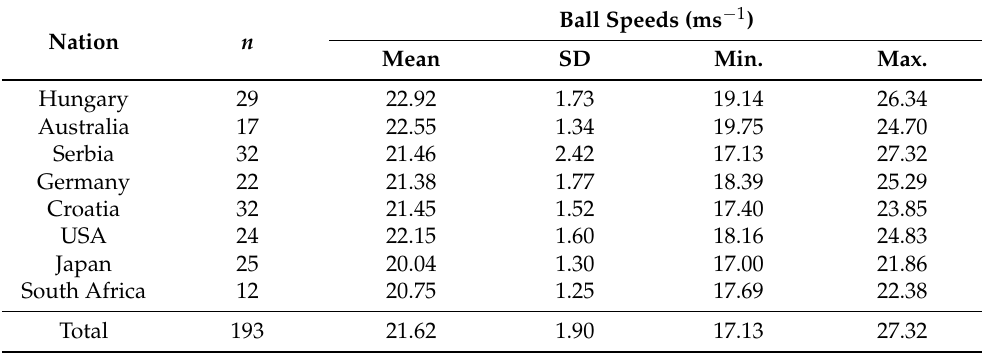
Table 3. Ball speeds during goal throw with drive shot at time t3 (leaving hand), only for direct and bounced, unimpeded drive shots without technique faults, from a distance of at least 6 m and with ball speeds higher than 17 ms − 1